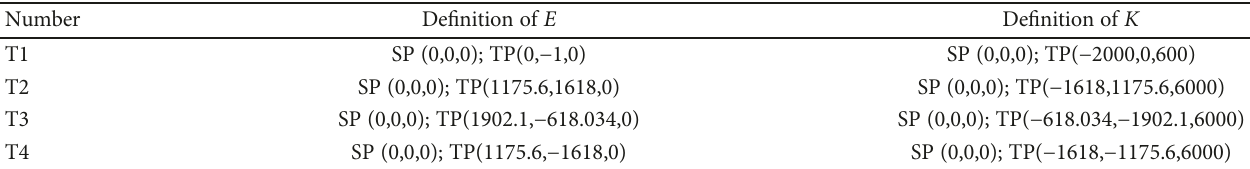
Figure 4: A schematic of a cirrus cloud detected by round MIMO array. Table 1: Parameter settings of the transmitting antennas in HFSS software.